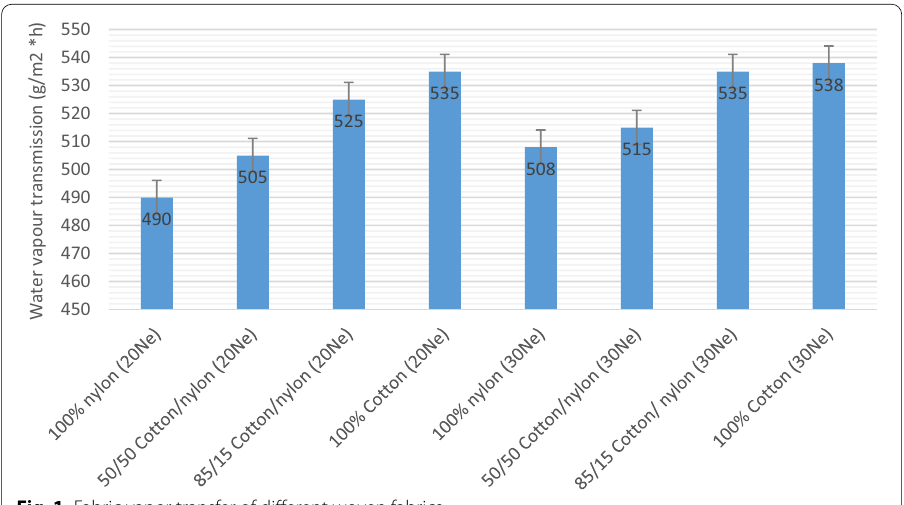
Fig. 1 Fabric vapor transfer of different woven